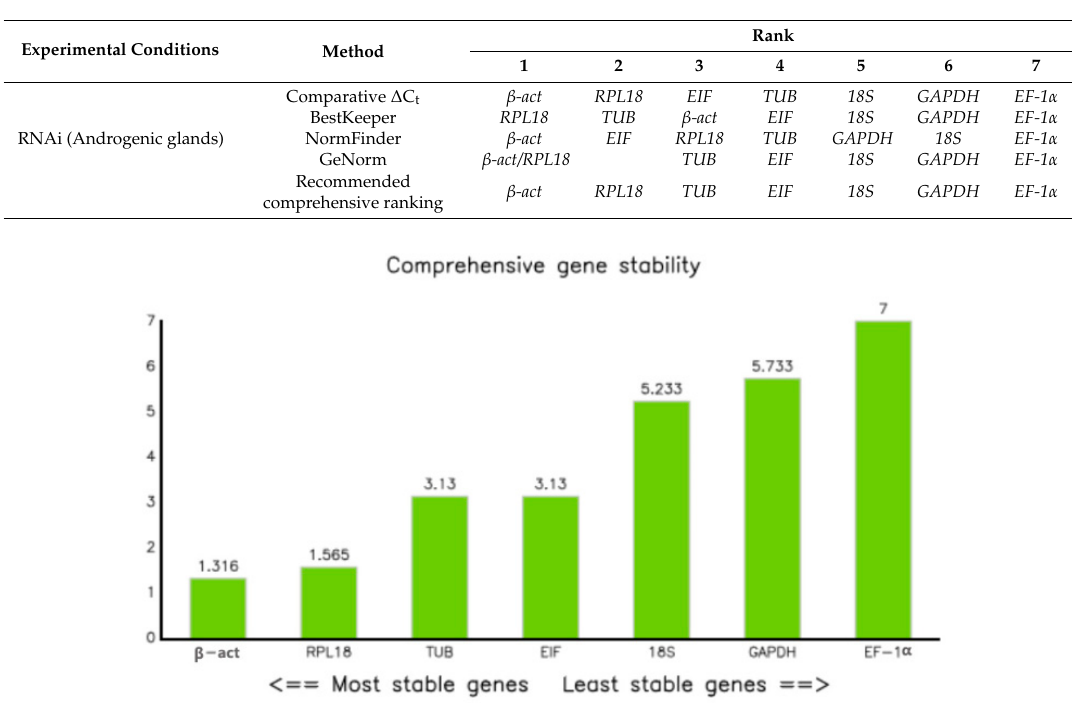
Table 4. Ranking of reference genes of RNAi by different methods.